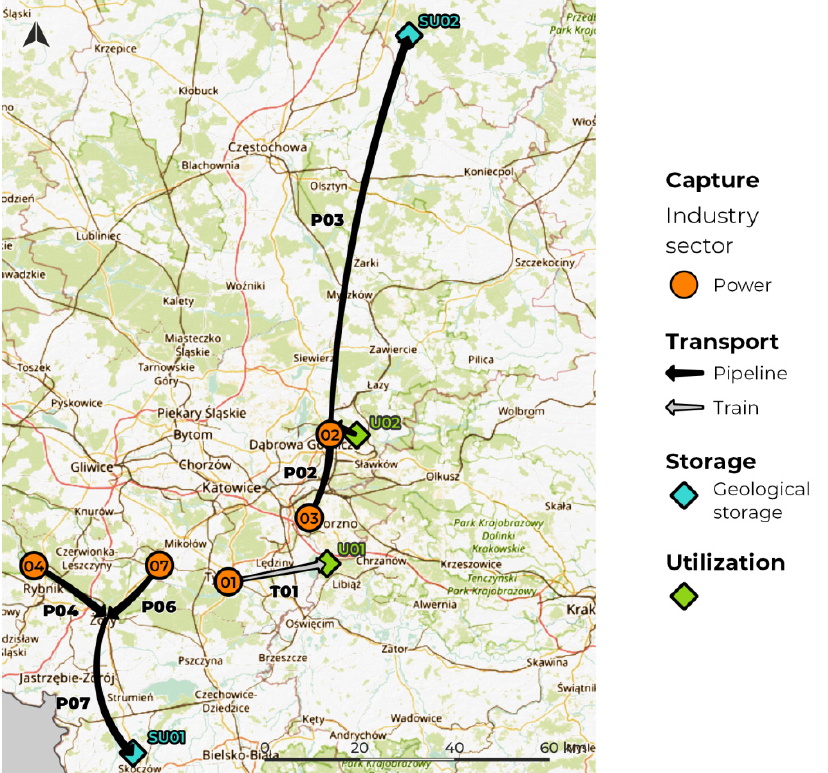
Figure 4. Location of the emitters, transport routes, storage sites and utilisation facilities assumed in the baseline scenario (source: STRATEGY CCUS). Table 4. The long-term baseline scenario assumptions (up to